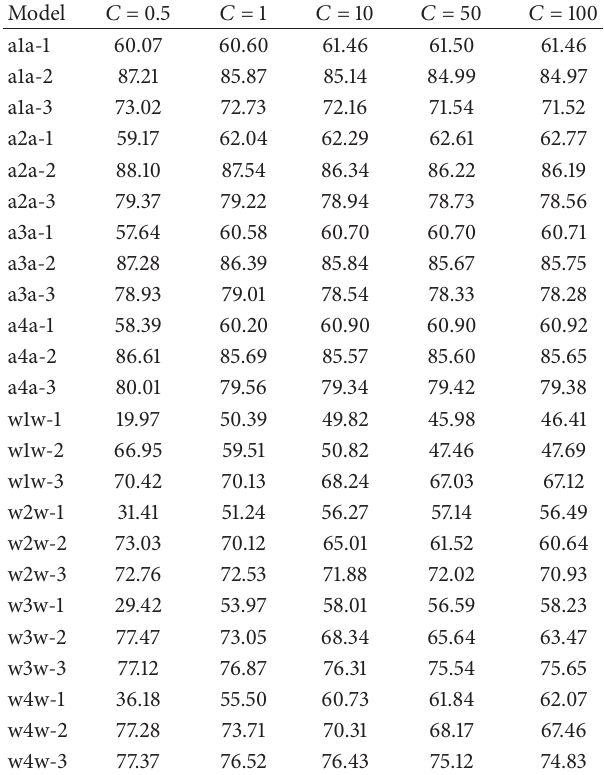
Table 2: Systematic precision at different parameter values (%). Model